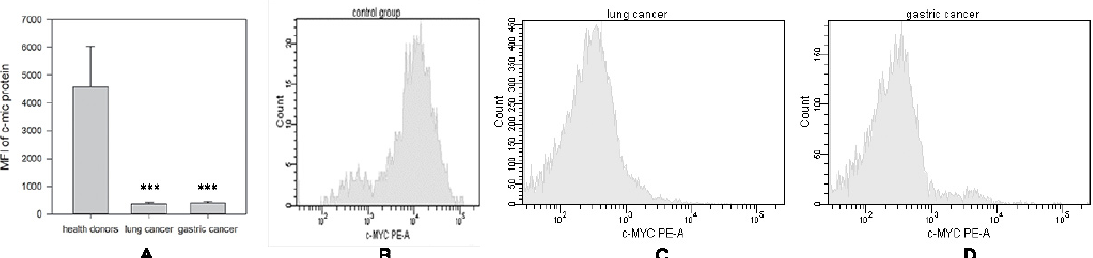
Figure 2. Differences in c-Myc protein expression in NK cells harvested from healthy donors and cancer patients. NK cells were isolated from the peripheral blood samples by negative selection using Dynabeads. C-myc-protein expression was determined as described in M&M. ( A ) Data of mean fluorescent intensity (MFI) are shown as the mean ± SEM (ANOVA). ( B ) C-myc-protein expression in peripheral NK cells from one of 10 representative healthy donors. ( C ) C-myc-protein expression in peripheral NK cells from one of 7 representative patients with lung cancer. ( D ) C-myc-protein expression in peripheral NK cells from one of 12 representative patients with gastric cancer.